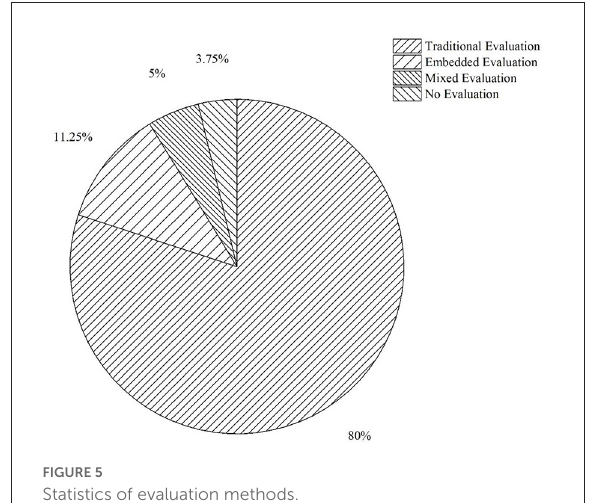
FIGURE5 Statistics of evaluation